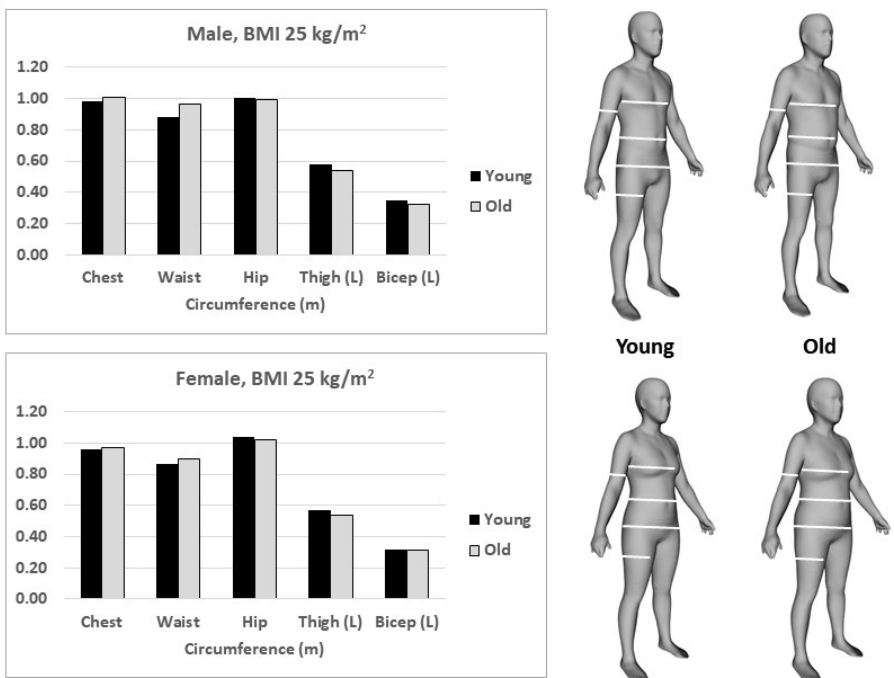
Figure 7. Circumferences of young ( ≤ age 40 yrs) and old (>age 40 yrs) male and female humanoid avatars (right) at a BMI of 25 kg/m 2 are shown on the left. For details of the ‘Shape Up! Adults study’ sample, see Supplementary Materials Table S1).